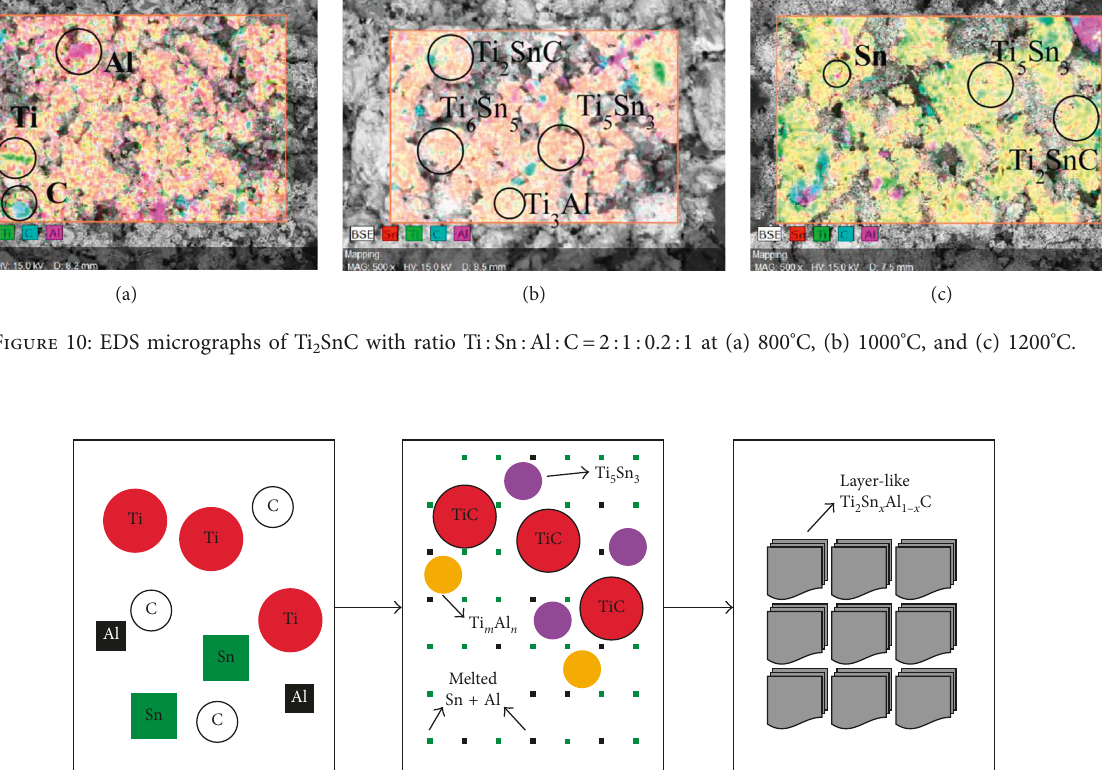
2 Sn x Al 1 x C. (a) Starting x C. − −